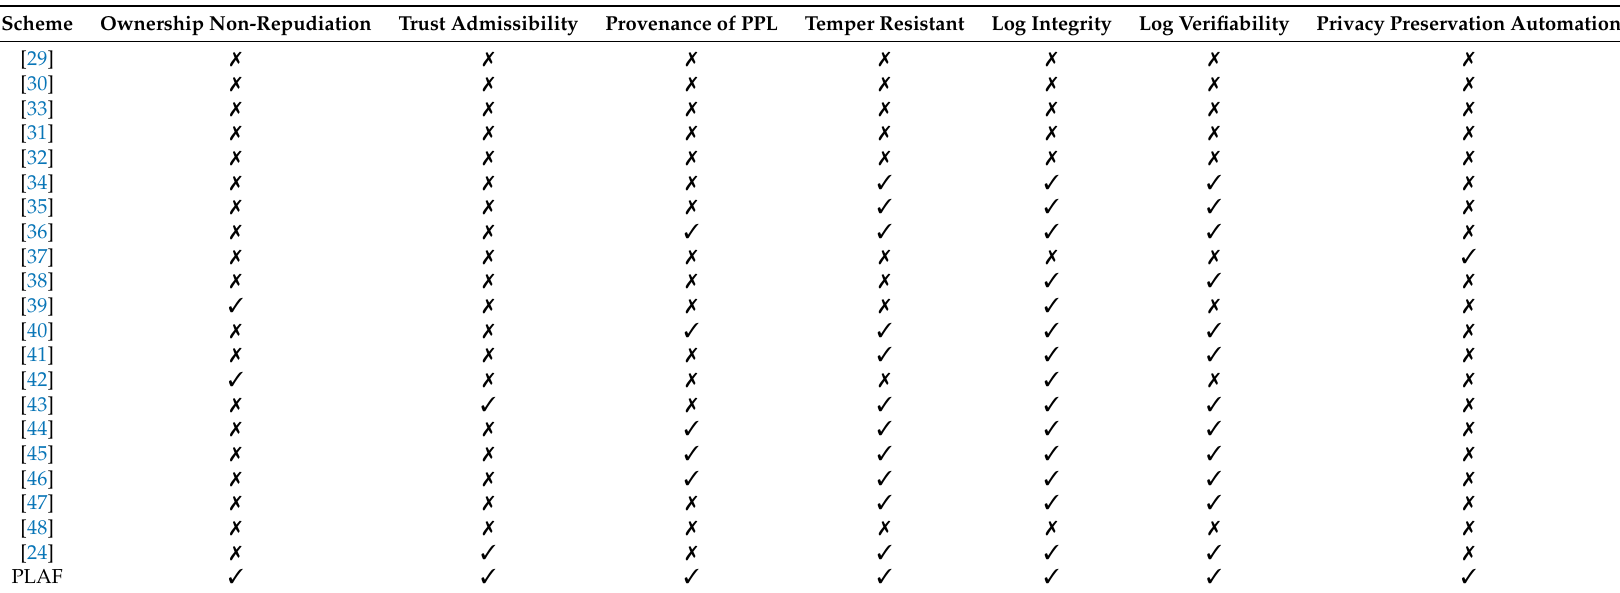
Table 6. Security comparison PLAF with existing